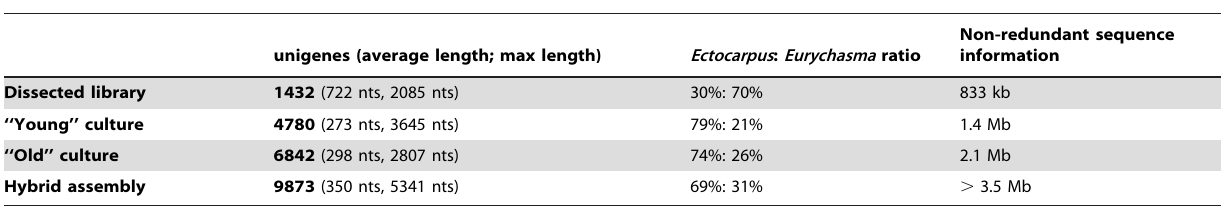
Table 1. Assembly statistics, individual cDNA libraries and final hybrid